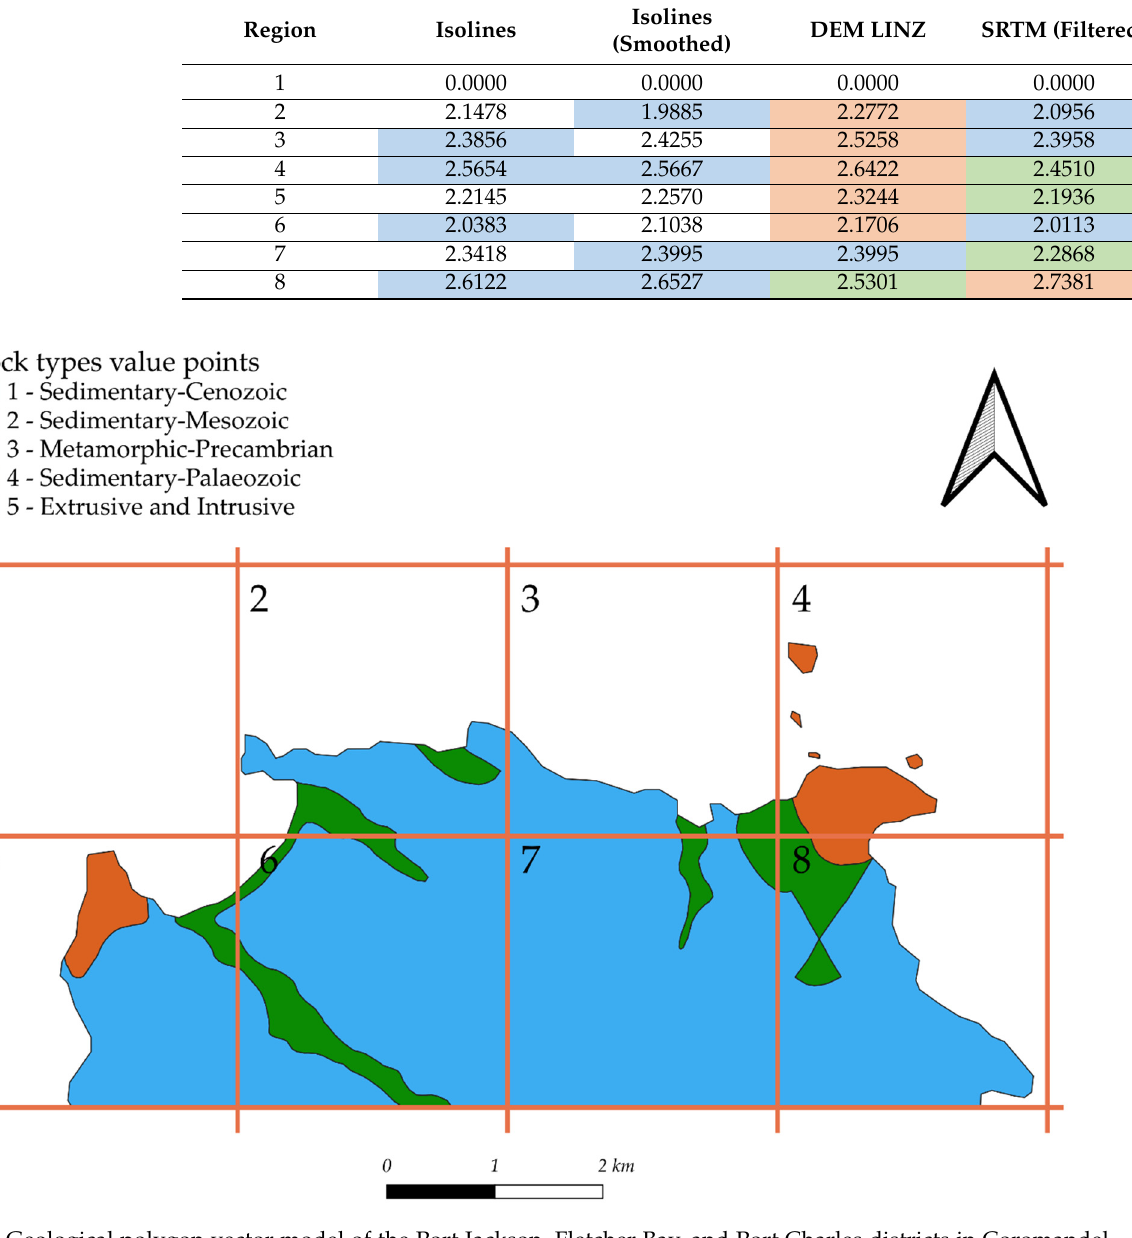
Figure 6. Geological polygon vector model of the Port Jackson, Fletcher Bay, and Port Charles districts in Coromandel Peninsula. According to geological values (Table 3). the green color represents 1 (the lowest value Sedimentary–Cenozoic), blue color 2 (low value Sedimentary–Mesozoic), purple 3 (middle value Metamorphic–Precambrian), yellow 4 (high value Sedimentary–Paleozoic), and orange is Intrusive and Extrusive). Additionally, the grid of 8 cells representing regions of 6.25 km 2 is shown.